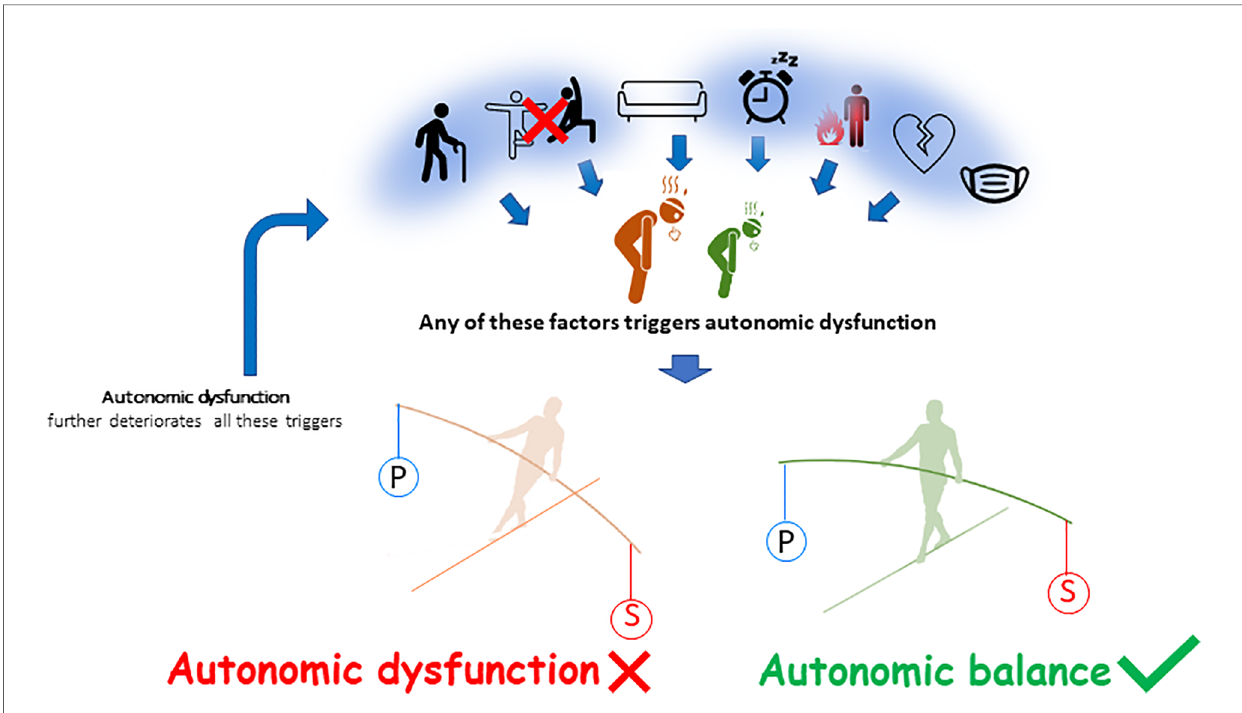
FIGURE 3 Determinants of autonomic dysfunction. From left to right, ageing, physical inactivity, sedentary behavior, sleep disorders, in fl ammation, cardiovascular diseases and more generally chronic disease may contribute to chronic fatigue and to a global decrease in autonomic function. There is a predominance in the sympathetic activity (S) to the detriment of the parasympathetic activity (P). The autonomic imbalance or autonomic dysfunction further increases fatigue (86).